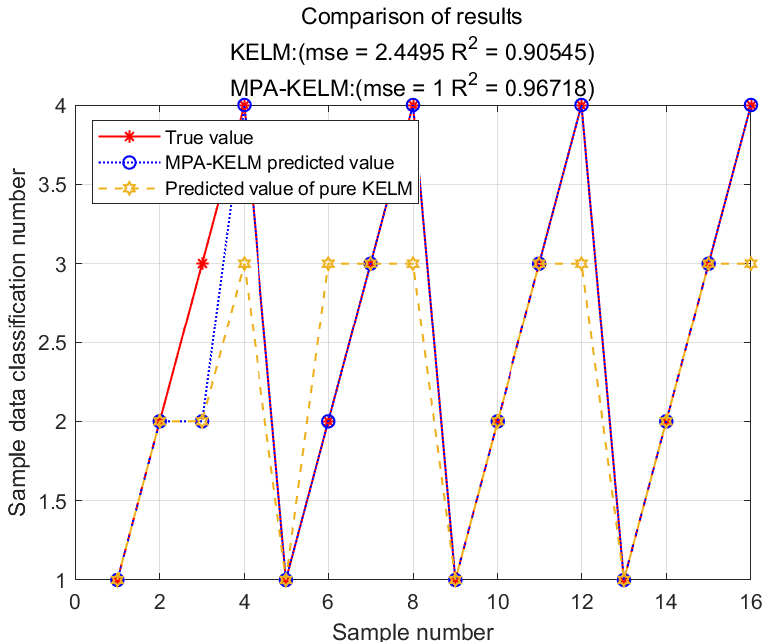
Figure 4. Comparison of model prediction results.